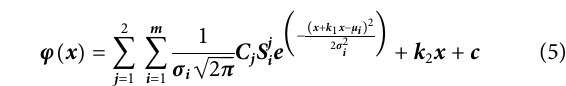
Frontiers in Physics |